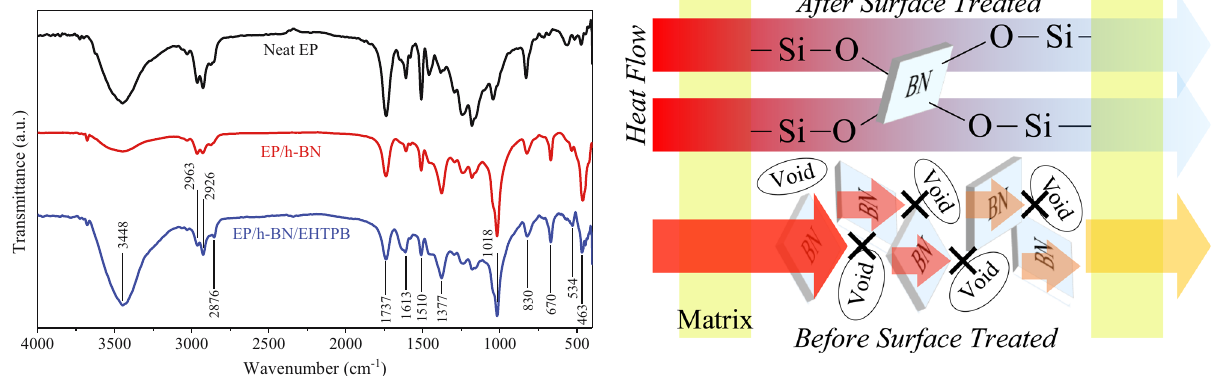
Figure 6: Mechanism of surface modi fi cation to improve the thermal